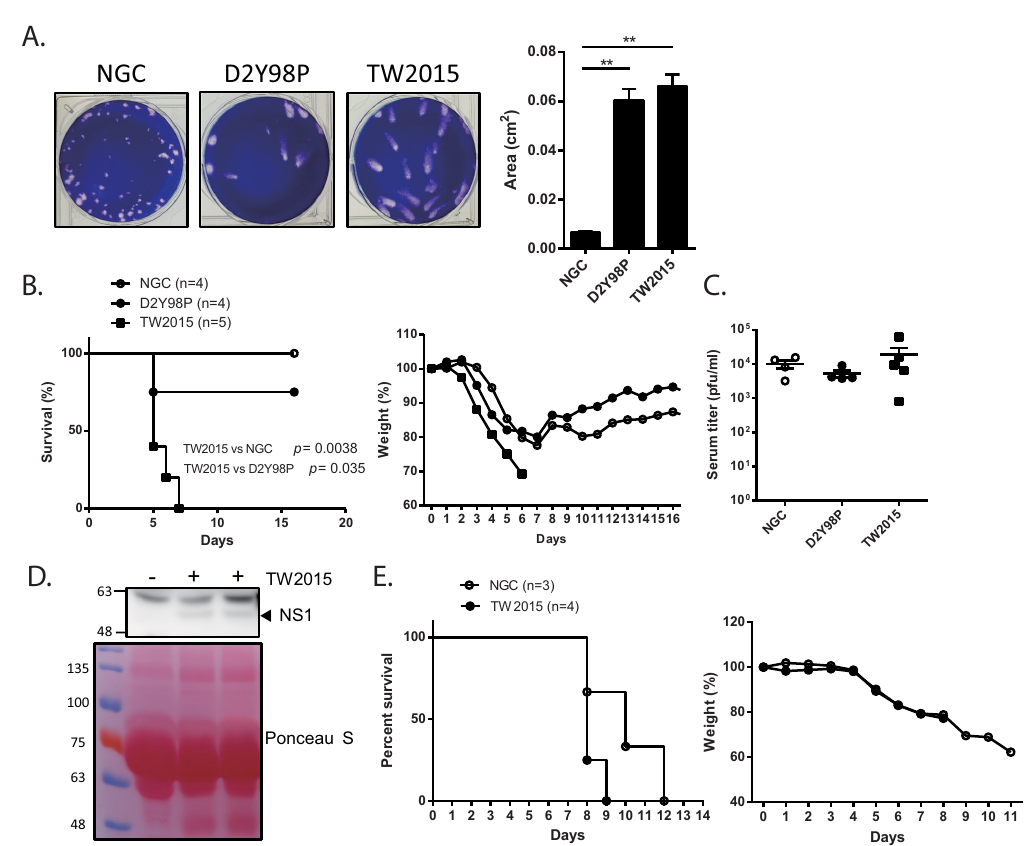
Fig 1. A clinical isolate of the dengue virus type 2 (DENV-2) TW2015 strain was highly virulent in Stat1 -/- and AGB6 mice. (A) Plaques of DENV-2 strains (NGC, D2Y98P, and TW2015) formed in BHK-21 cells were photographed and plaque size was quantified by Image J software (n = 14–40). �� p < 0.01 (B) Survival and body weight of Stat1 -/- mice infected with DENV-2 strains (iv, 1000 pfu/mouse). (C) Viremia, via plaque assay, in Stat1 -/- mouse serum collected on day 3 post-infection with DENV-2. (D) NS1 expression in serum samples from the TW2015-infected Stat1 -/- mice via immunoblotting with anti- NS1 antibody. The ponceau S was used to stain the protein blotted to the membrane. (E) Survival and body weight of AGB6 mice infected with the NGC or TW2015 virus (iv, 1000